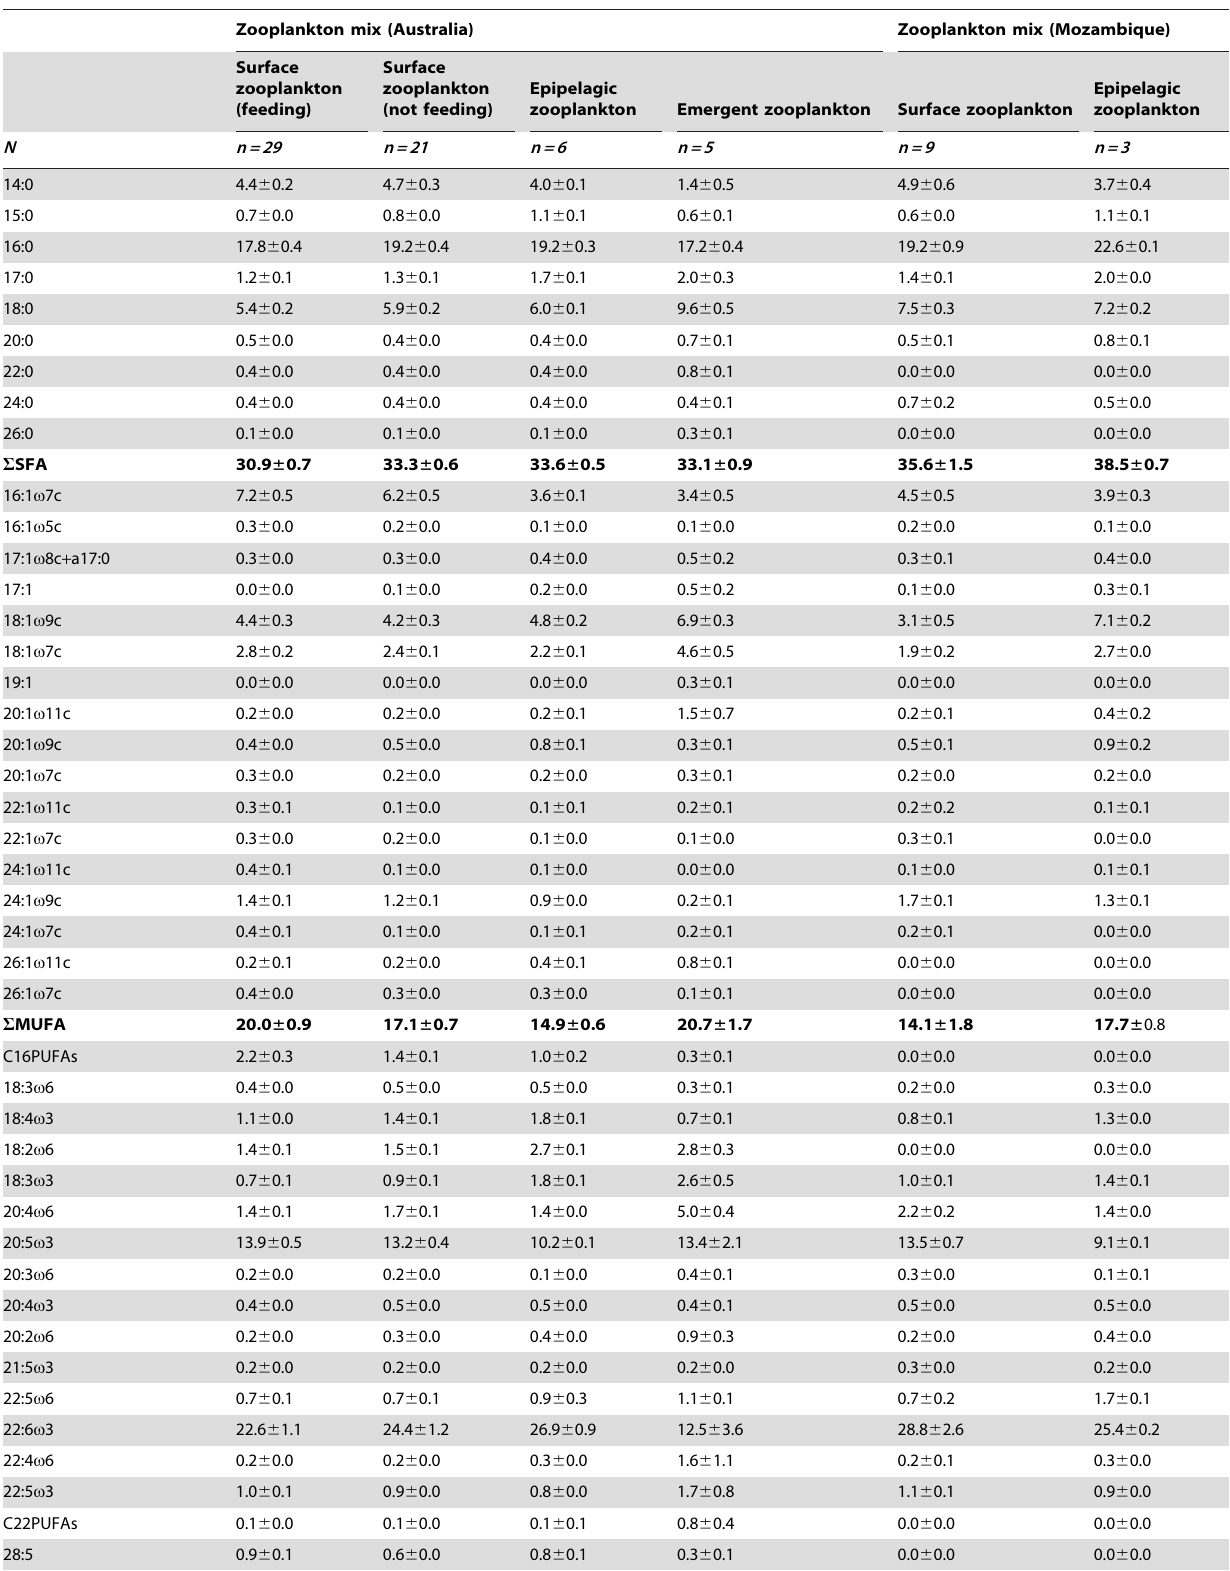
Table 3. Fatty acid composition (% of total FA) of zooplankton samples collected off eastern Australia and Mozambique.